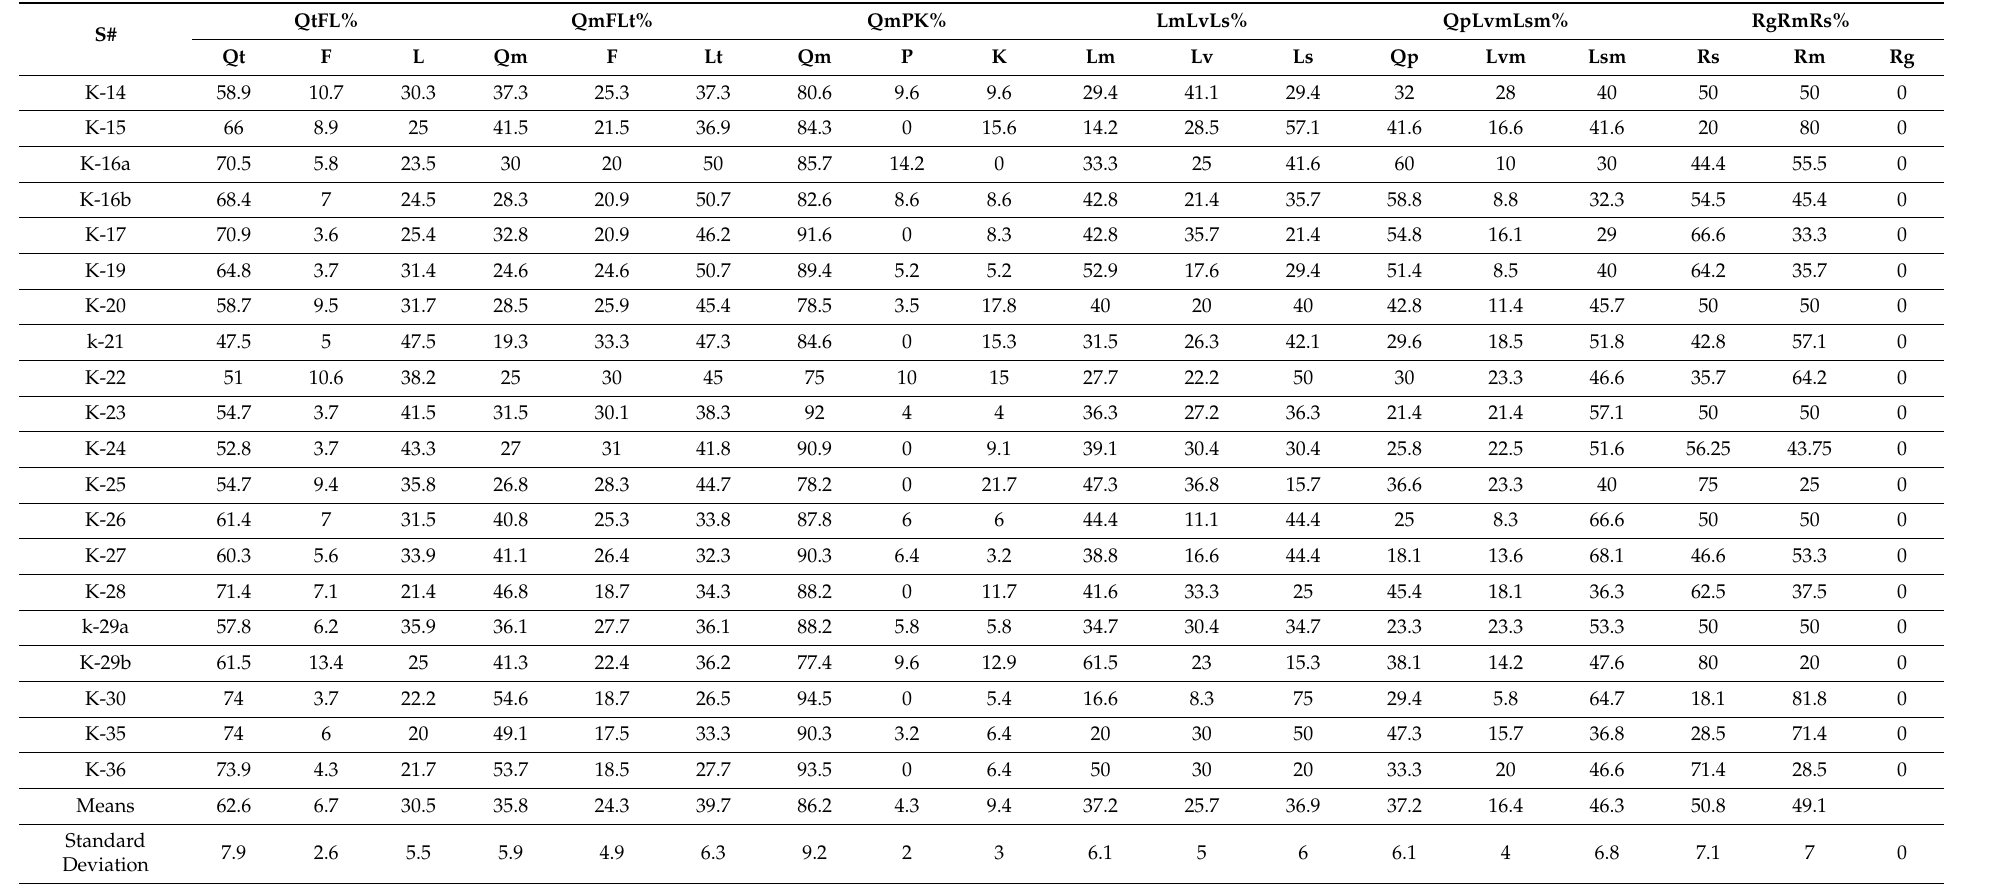
Table 2. Recalculated detritus of Kuldana